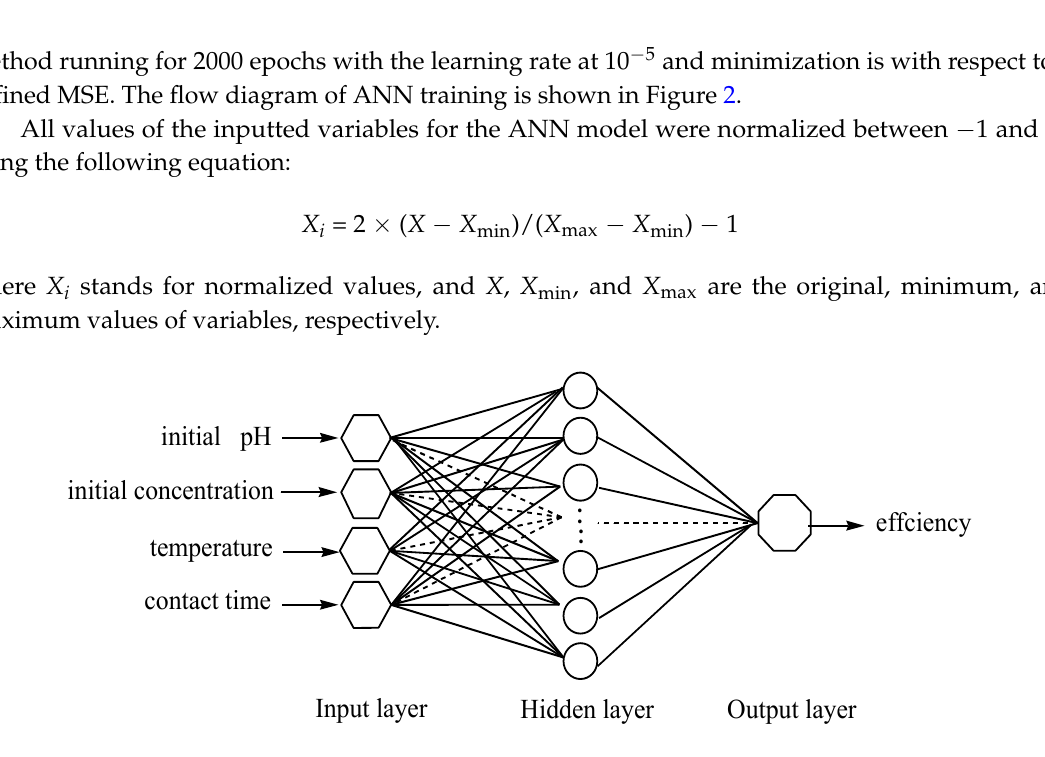
Figure 1. Simple illustration of the artificial neural network (ANN) structure.